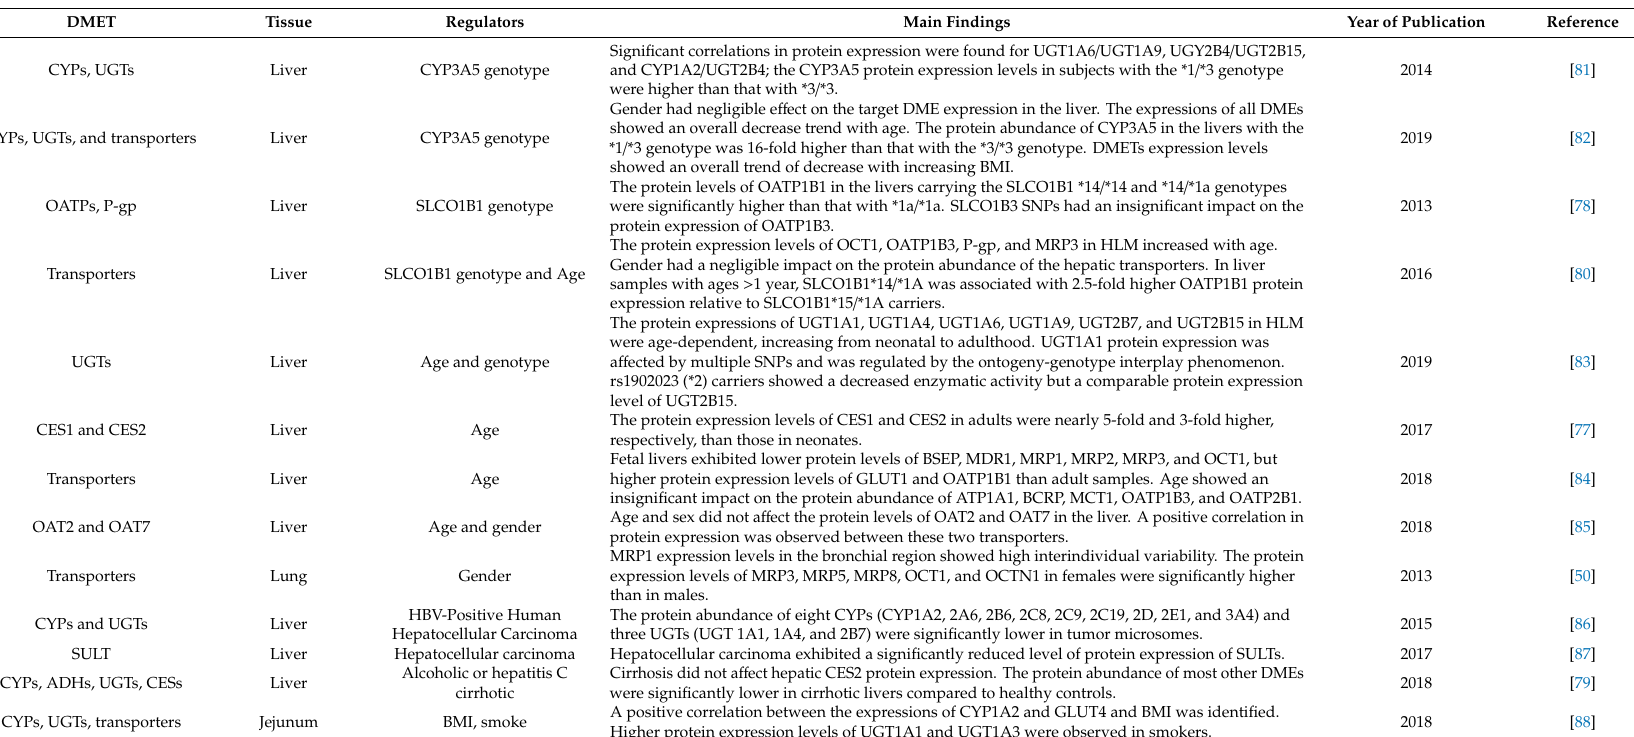
Table 3. Regulating factors contributing to interindividual variability in DMET protein expression.